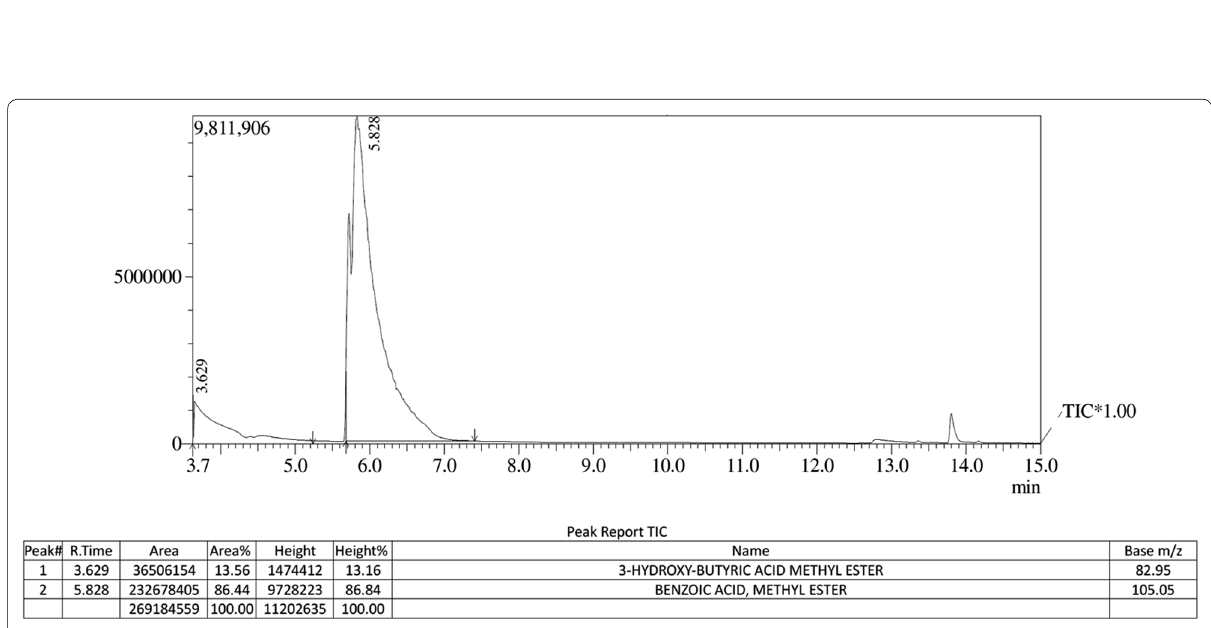
Fig. 3 Gas chromatogram of PHB obtained from recombinant E.